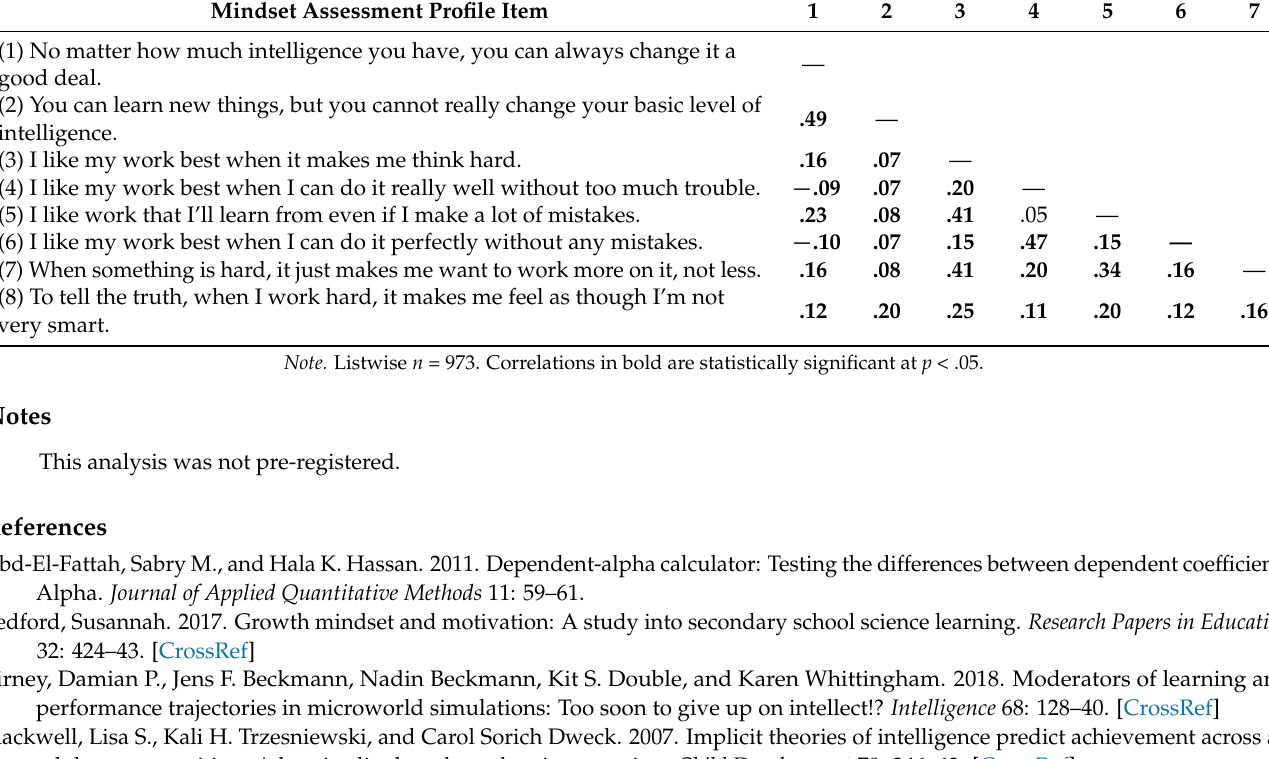
Table A1. Correlation matrix with all items from the Mindset Assessment Profile. Mindset Assessment Profile